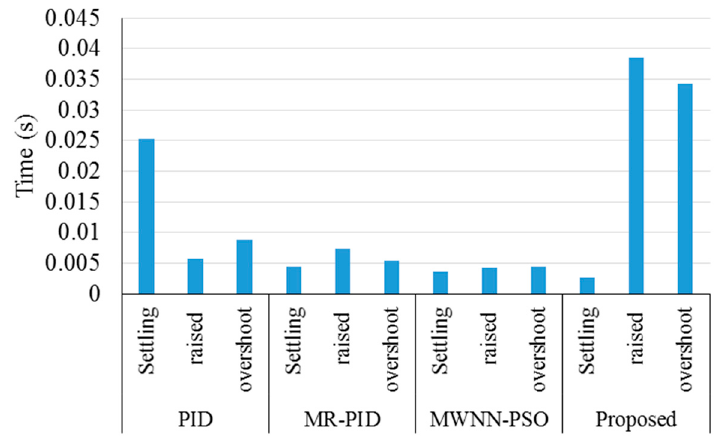
Figure 10. Comparing the time values for the study by Aruna (2016) [61].